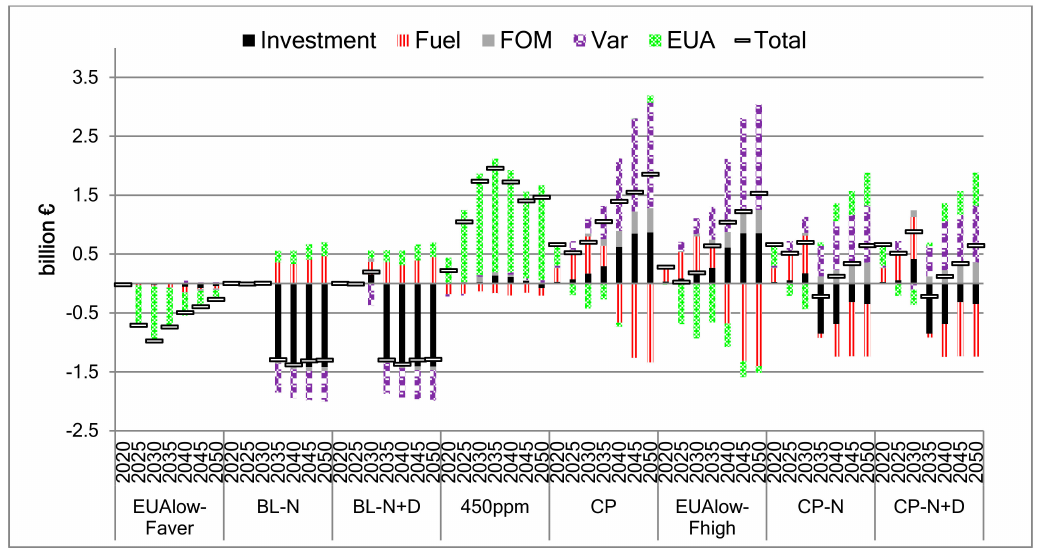
Figure 8. Total annualized costs for TEL2 policy, cost difference compared to TEL2 BL reference case. Note: Average over 5-year time span of annualized cost over (for instance, the 2020 value corresponds to the average of annual annualized cost from 2018 to 2022). The difference in the cumulative sum of total annual annualized costs from 2020 to 2050 is − € 26.5bn (BL-N), − € 25.4bn (BL-N+D), − € 18bn (EUAlow-Faver), + € 13.6bn (CP-N), + € 14.6bn (CP-N+D), + € 24.4bn (EUAlow-Fhigh), + € 38.5bn (CP), and + € 47.6bn (450 ppm), compared to the TEL2 BL reference case. For a comparison, 1 bln. € in 2020 corresponds to about 0.5% GDP predicted for the same